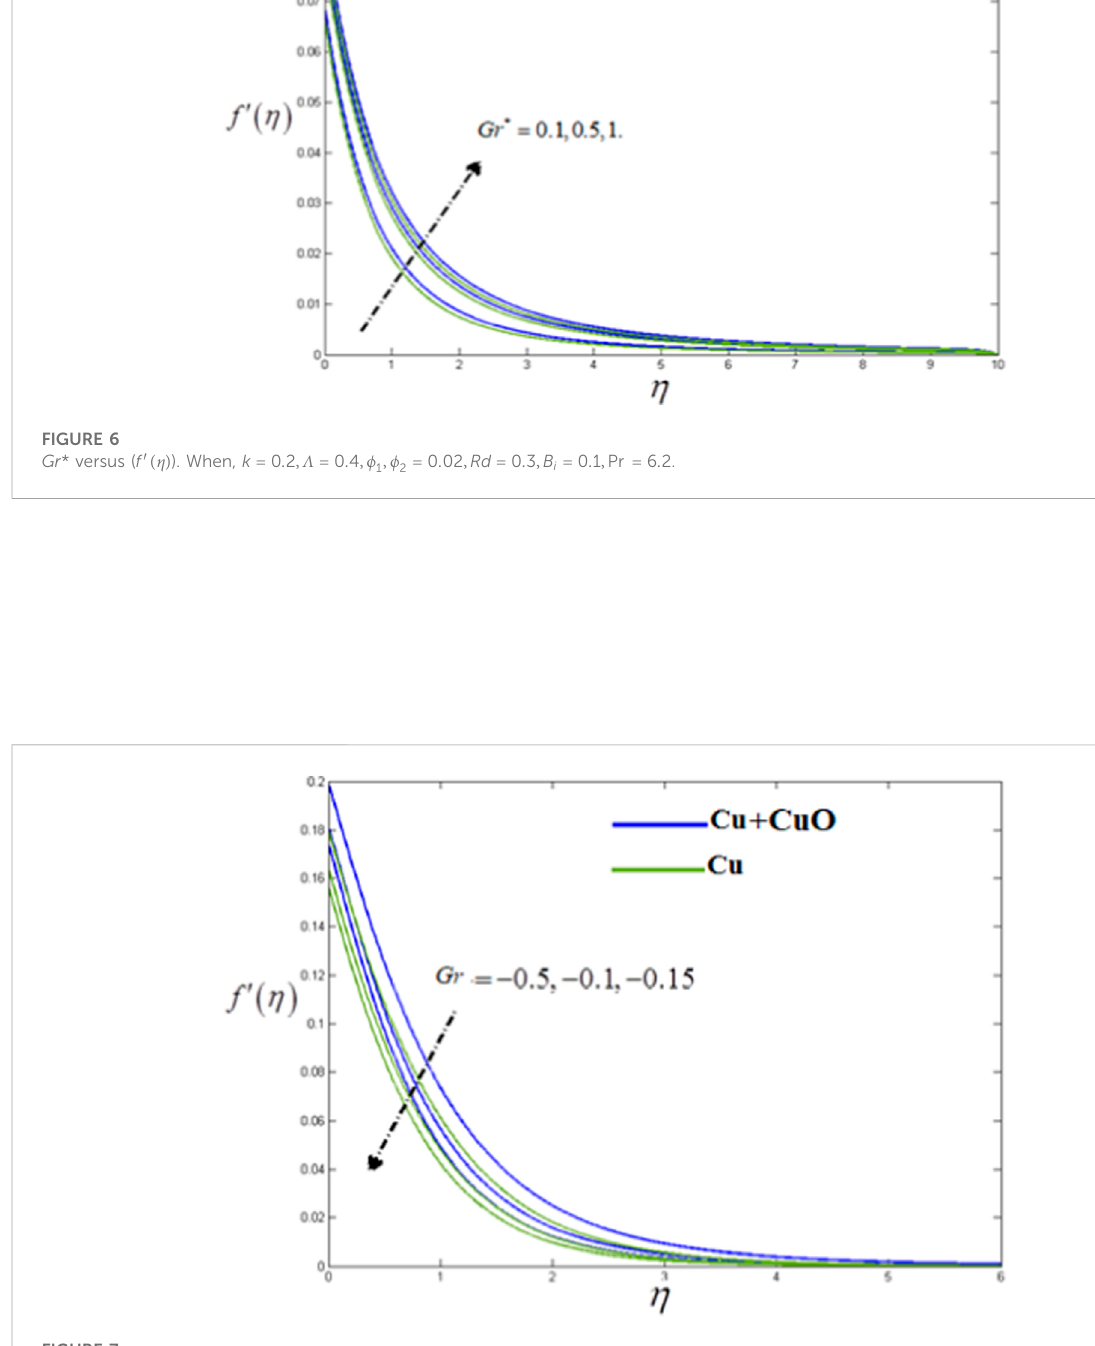
FIGURE 7 Gr versus f ′ ( η ) . When, k (cid:2) 0 . 2 , Λ (cid:2) 0 . 4 , ϕ 1 , ϕ 2 (cid:2) 0 . 02 , Rd (cid:2) 0 . 3 , B i (cid:2) 0 . 1 , Pr (cid:2) 6 .